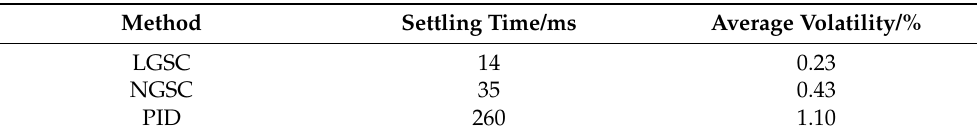
Table 2. Performance analysis of different control methods.